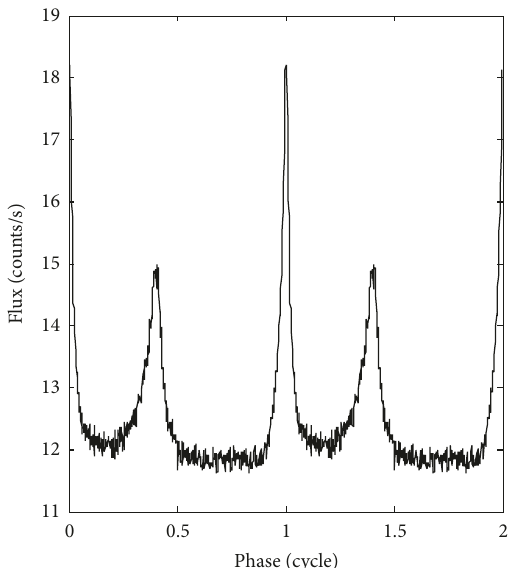
Figure 7: Crab profiles in the 0.5 ∼ 9 keV band from all 162 observa-